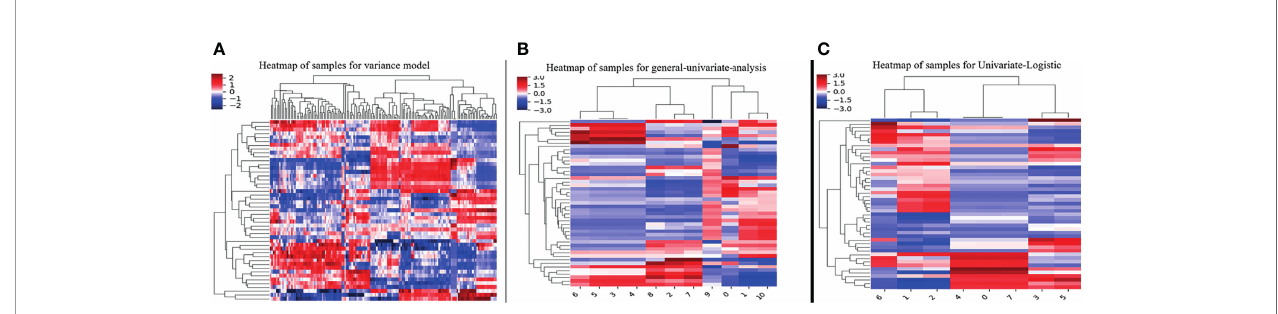
FIGURE 2 | The steps of texture features reduction and selection by the method of (A) variance, (B) univariate analysis, and (C) univariate